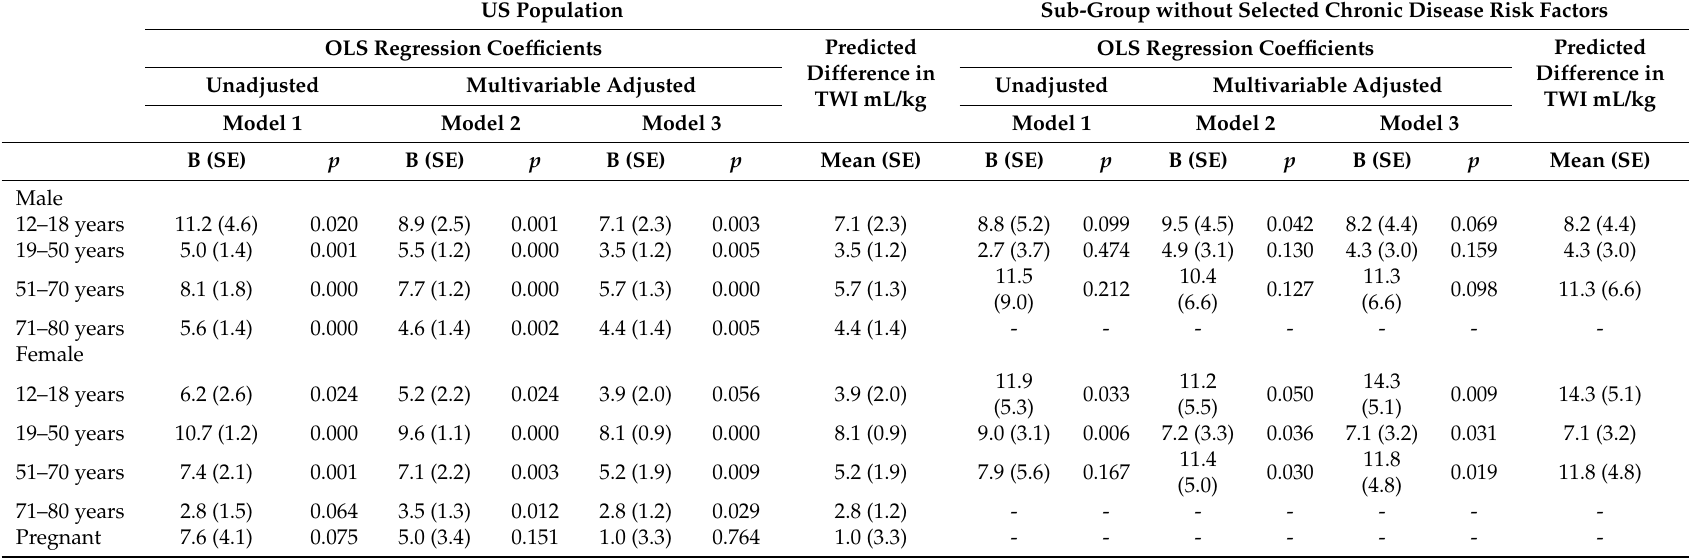
Table 6. Mean difference in TWI associated with meeting the hydration criteria versus not meeting the hydration criteria for the US population aged 12–80 years and the sub-group aged 12–70 years without selected chronic disease risk factors in 2009–2012. US